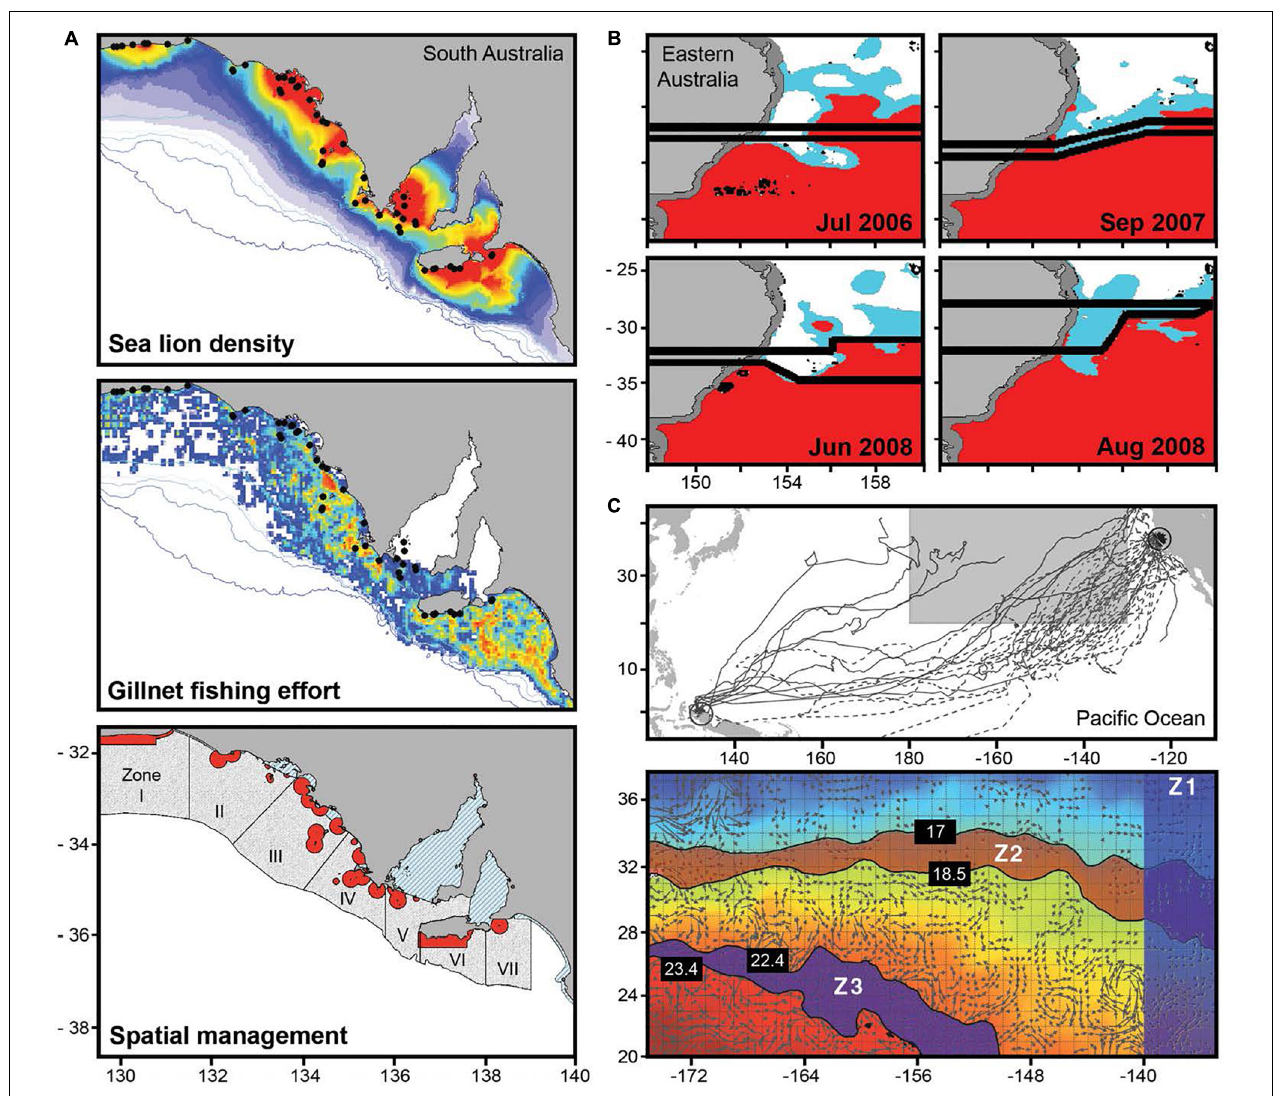
FIGURE 1 | Impact of tracking data in the management of demersal gillnet fisheries in south Australia (A) , eastern Australia longline fisheries (B) , and pelagic longline fisheries in Hawaii (C) . (A) Shows the detailed modeled at-sea density of Australian sea lions based on the combination of tracked movements from over 200 individuals from 48 breeding sites (black circles) with population models (top), which was integrated into a bycatch estimation model with the spatial distribution of demersal gillnet fishing effort (center) to estimate bycatch and develop spatial closures around all breeding colonies (in red, bottom) and bycatch trigger limits that enact temporal closures across seven zones (light gray, bottom) (adapted from Goldsworthy et al., 2010 and http://afma.gov.au). (B) Illustrates how management lines (black) that separate habitat types for southern bluefin tuna have been shifted according to habitat suitability predictions derived from tracking data. The figure shows habitat classed as ‘core’ where most tuna are predicted (80% suitability in red), ‘buffer’ representing a habitat transition zone (15% suitability in blue), and ‘OK’ where fewer tunas are expected (5% suitability in white) (adapted from Hobday et al., 2010). (C) Tracks of leatherback turtles (upper panel; n = 37, black solid and dashed lines) in relation to the region where > 95% of the Hawaii-based pelagic longline fishery operates (shaded box), and an example figure from TurtleWatch (lower panel) combining daily sea surface temperature (SST) and ocean current data with predicted locations of turtles. Zones Z1–Z3 are regions to avoid so as to reduce interactions with turtles (adapted from Howell et al.,